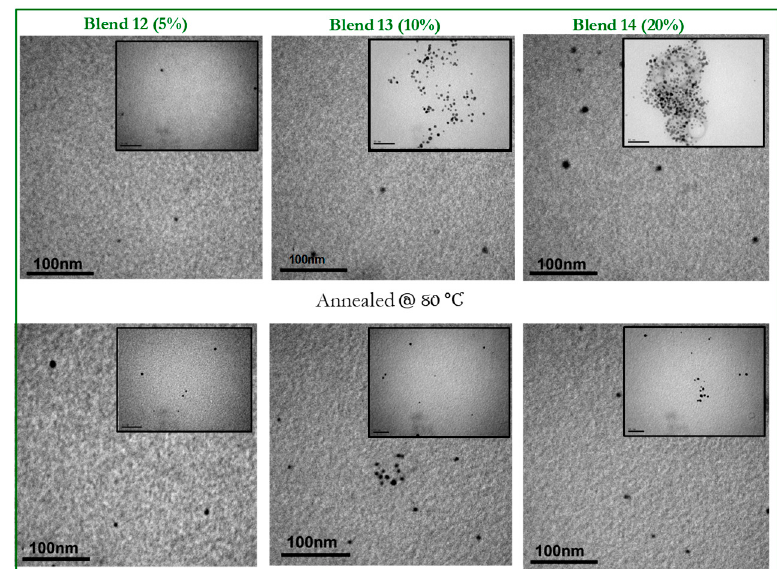
Figure 9. TEM images of blends 5–7 (PCDTBT:PC 71 BM 1:1 w/w containing 5%, 10% and 20% wt of P2,7C(HD)DTBT-PQPy without annealing (top images) and after annealing at 80 °C (bottom images). For the bigger images, the scale bars correspond to 100 nm, while for the inset images, they correspond to 50 nm.